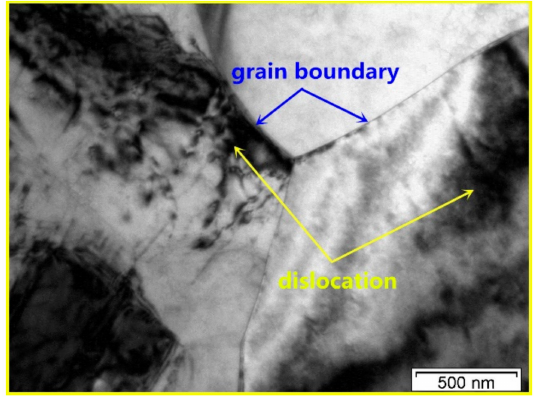
. ε = 0.002 s − 1 and T = 450 ◦